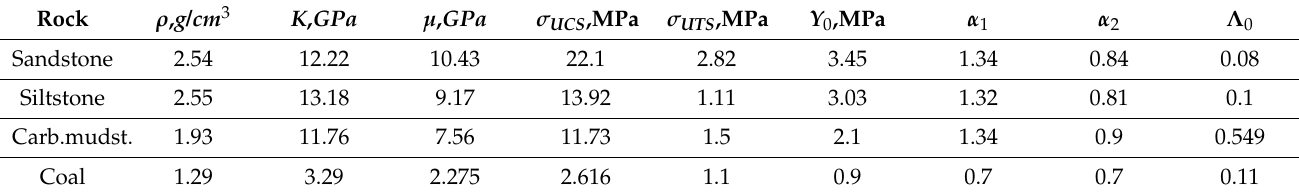
Table 1. Physical-mechanical properties of rocks used in